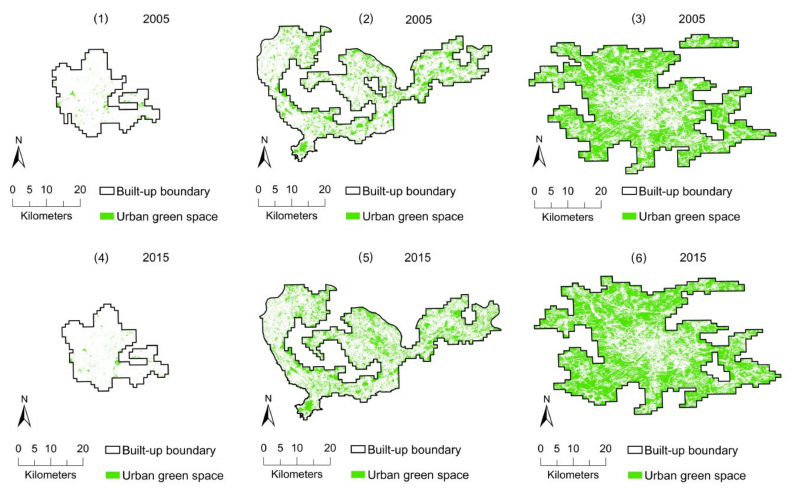
Figure 2. Distributions of urban green spaces in 2005 and 2015, examples of: the least green (Karachi) ( 1 ), median green (Shenzhen) ( 2 ), and greenest (Moscow) ( 3 ) megacity in 2005; and the least green (Karachi) ( 4 ), median green (Shenzhen) ( 5 ), and greenest (Moscow) ( 6 ) megacity in